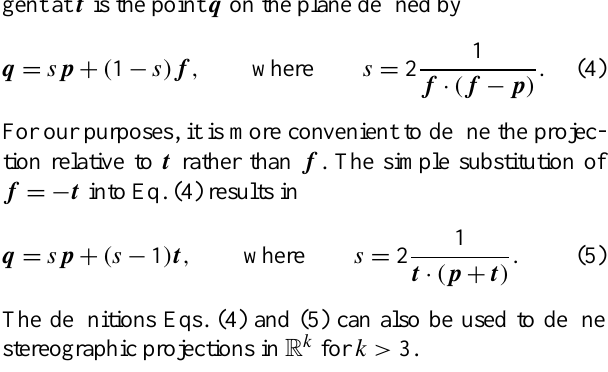
Fig. 4. Left: An overlapping subdivision of the sphere into N = 12 spherical caps. The cap centres t k are the projections onto the sphere of the centroids of the 12 pentagons of the inscribed regular icosahedron. Each coloured ring represents the edge of cap of radius r k . Right: A 10,242 generator Delaunay triangulation by the parallel algorithm